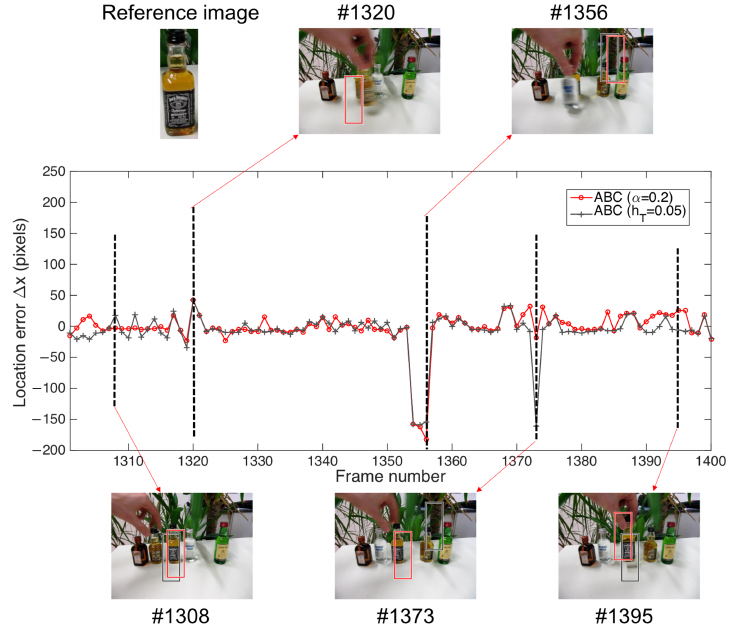
Figure 15. Comparison of two cases for threshold selection.